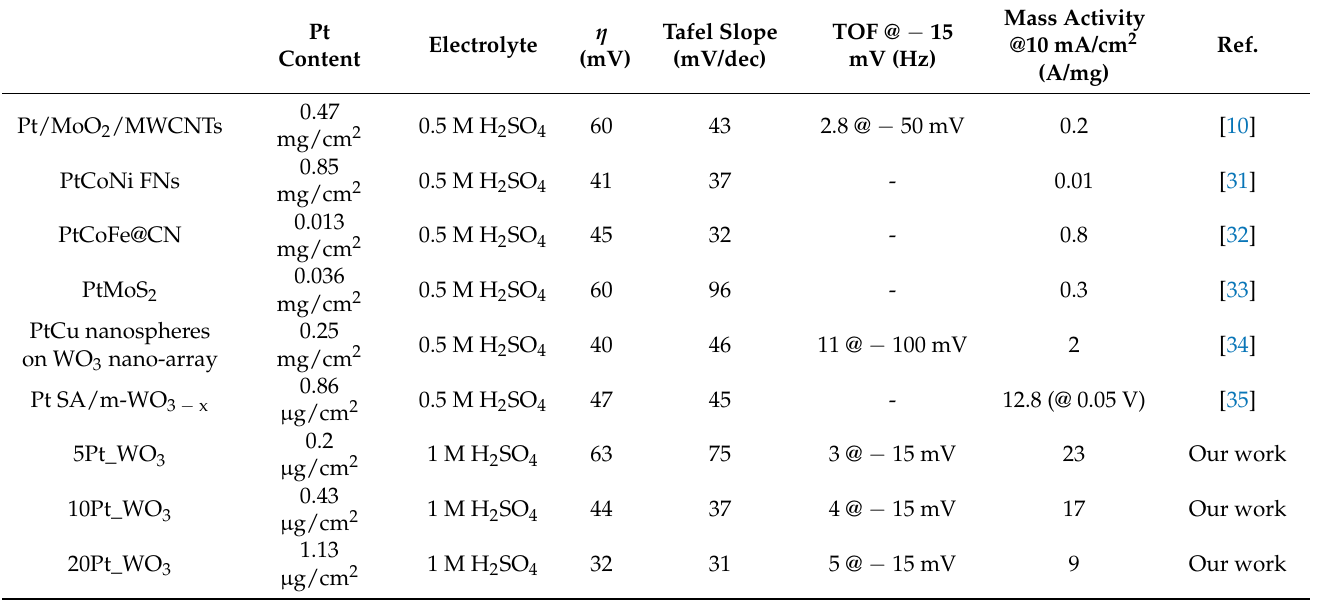
Table 2. Comparison between the state of the art on Pt-decorated metal oxide frameworks and our Pt-decorated electrodes.